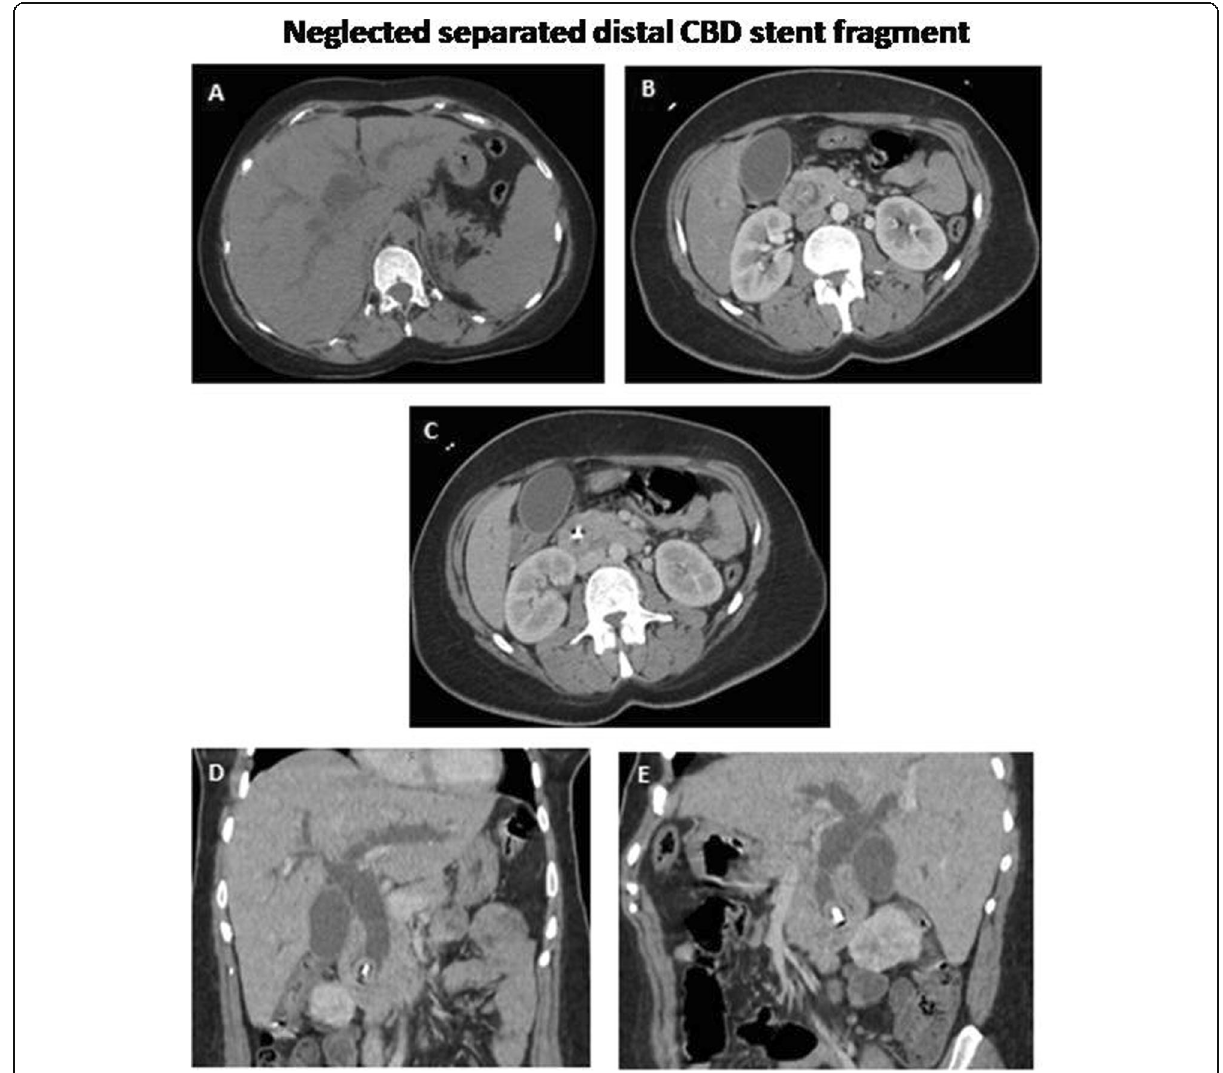
Fig. 7 Neglected separated distal CBD stent fragment. Benign obstructive jaundice due to distal CBD sludge surrounding neglected separated CBD stent fragment. Female patient, 34 years old, presented with persistent jaundice, fever, and pruritus (history of CBD stent removal). a Axial pre-contrast image showing moderate intra-hepatic biliary radical dilatation. b , c Axial contrast (arterial and portal phase) images showing distal CBD dense and turbid surrounding separated dense CBD stent fragment. d , e Coronal and sagittal oblique reformatted MDCT cholangiography images showing more clearly the markedly dilated CBD with distal impacted stent fragment surrounded by concentric